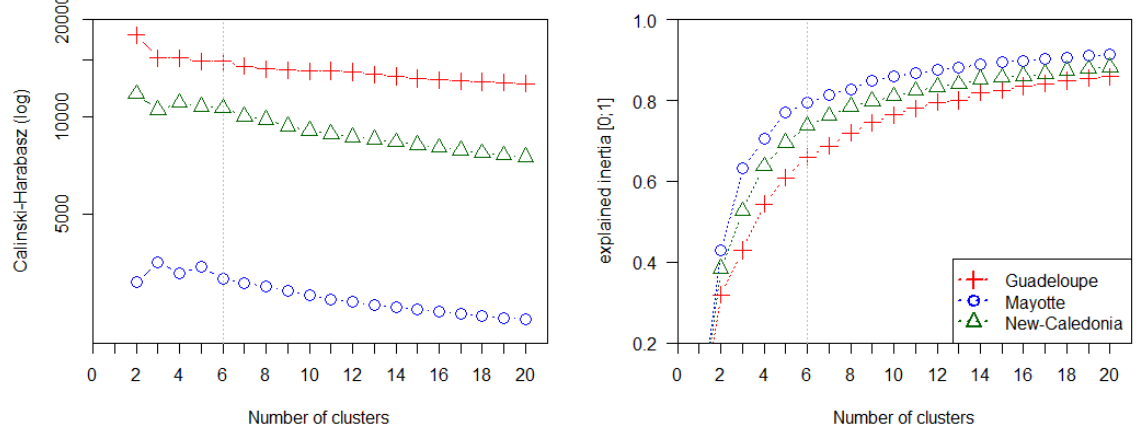
Figure 3. Calinski-Harabasz index and explained inertia values according to different number of